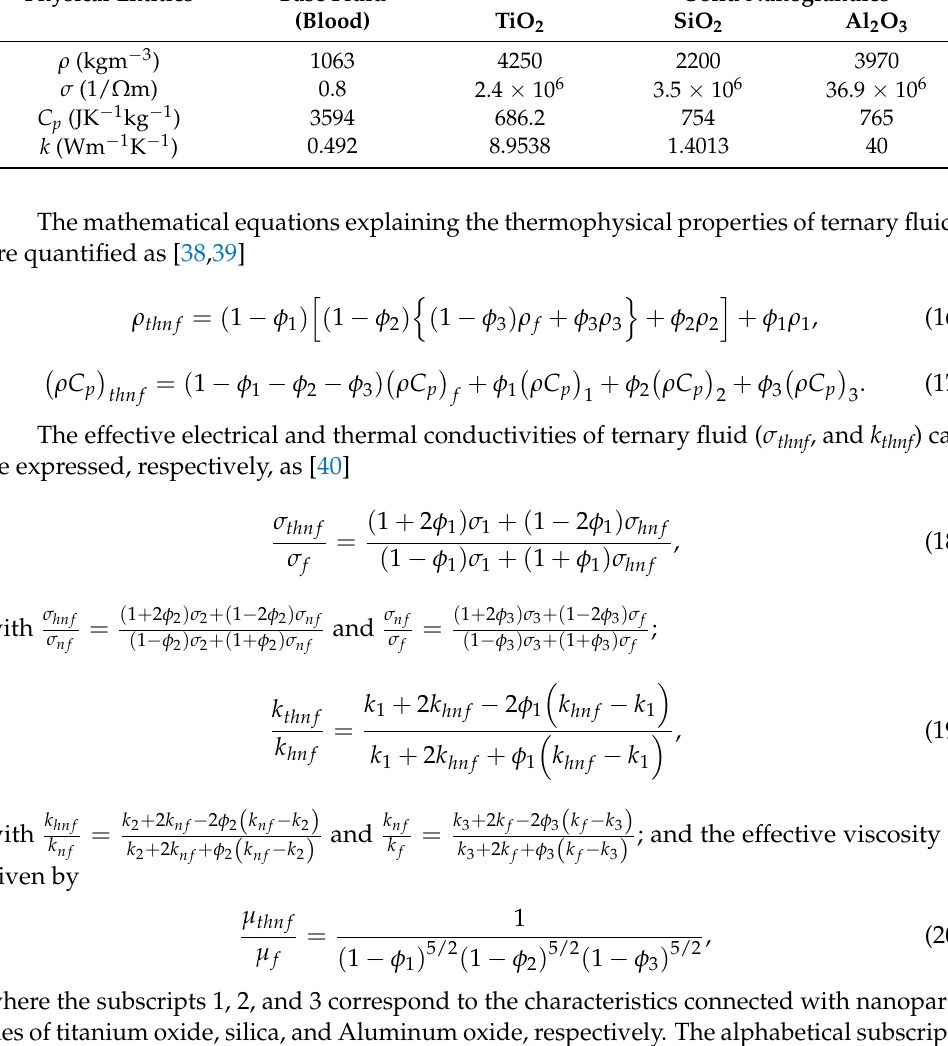
Physical Entities Base Fluid Solid